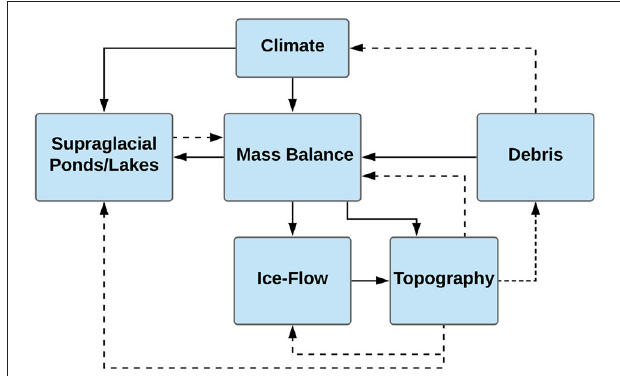
FIGURE 9 | Diagram illustrating the interactions between key controlling factors discussed in this paper that govern the dynamics of a debris-covered glacier. The feedbacks (dashed lines) are important to the system as they may increase a glacier’s sensitivity to climate change over time.